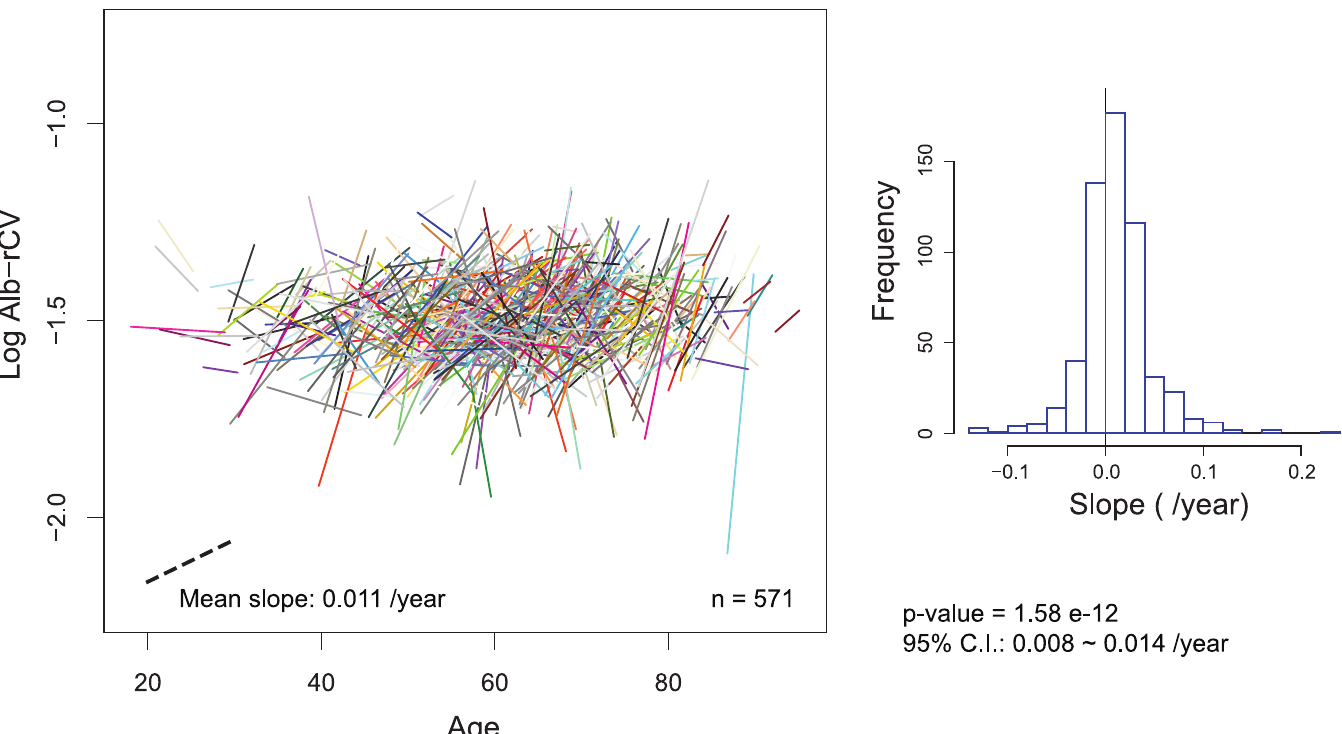
Fig 11. Overall Alb-rCV movement during the maintenance period of HD treatment. The regressionlines for the log Alb-rCV values are displayedin the same manneras that used for Alb-M in Fig